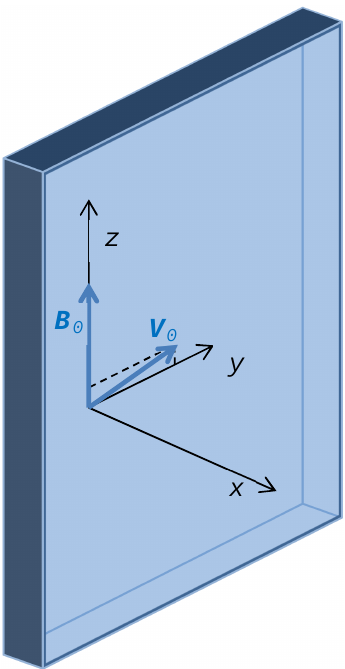
Fig. 2. Sketch of the slab configuration. A slab of plasma is embed- ded in a uniform background. The reference frame is chosen so that x is normal to the structure and the magnetic field B 0 points along the z axis at the centre of the slab; the y axis completes the right- handed frame. The flow V 0 in the slab may have any orientation, although most often it is taken here along the y